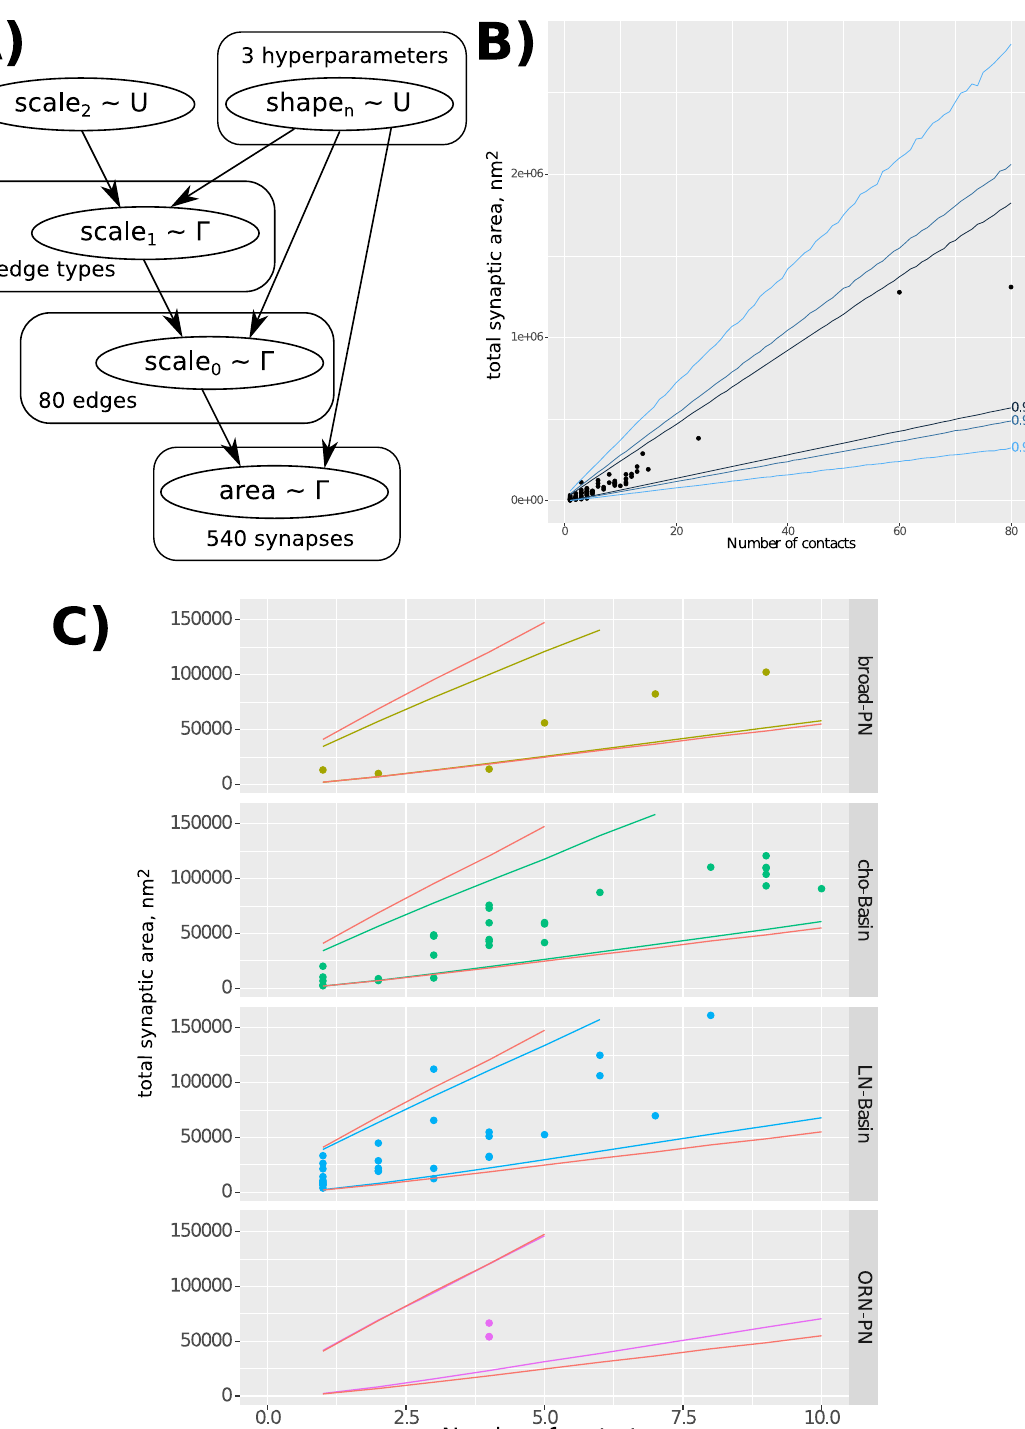
Fig 4. Bayesian hierarchical modelling of distributions of synapse areas across graph edges and edge types. A) Model dependency graph, showing how each level parametrises the levels below it, and the number of samples available at each level. B) Results of sampling from the generated model, including the bounds in which 90%, 95%, and 99% of samples fall, demonstrating that our data is in line with the model’s expectation. C) Comparing the results of sampling sub-models with a fixed edge type with the full joint model (red lines): the small narrowing of the result intervals suggests that the edge type does not have predictive power of the relationship between contact number and contact area for a graph edge, and therefore that the sizes of individual synapses do not differ much between edge types.